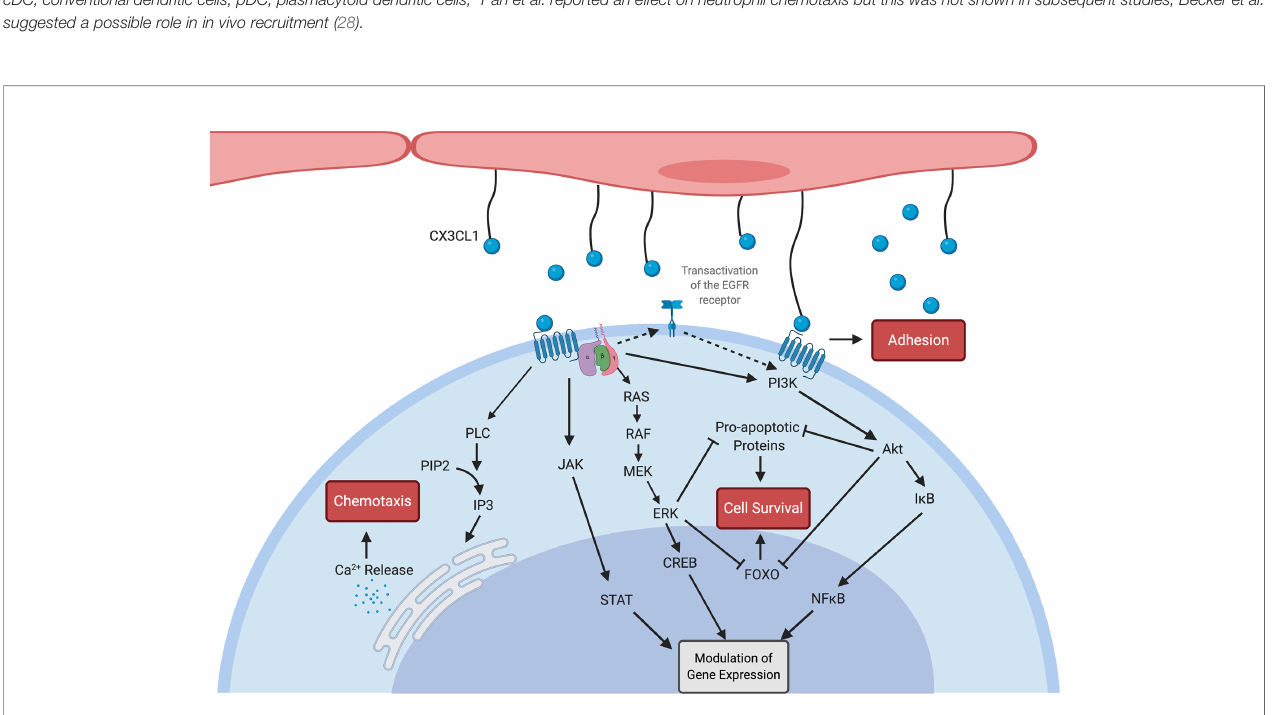
FIGURE 1 | Multiple signalling pathways are activated by both soluble and membrane-bound CX3CL1 (blue spheres) as outlined here. CX3CR1 is a G-protein coupled receptor linked to Gi and Gz proteins (8). Calcium release resulting in chemotaxis was demonstrated by Harrison et al. (29). CX3CL1 also contributes to intercellular adhesion through mechanisms which do not appear to be G-protein sensitive (5). Enhanced cellular survival is mediated by both the Akt and ERK pathways, including via transactivation of the EGFR receptor (16). CX3CL1 ligation of the CX3CR1 receptor also leads to nuclear translocation of transcription factors (30) including NF k B (31), CREB (32) and STAT (33) with resulting modulation of gene expression. Created with